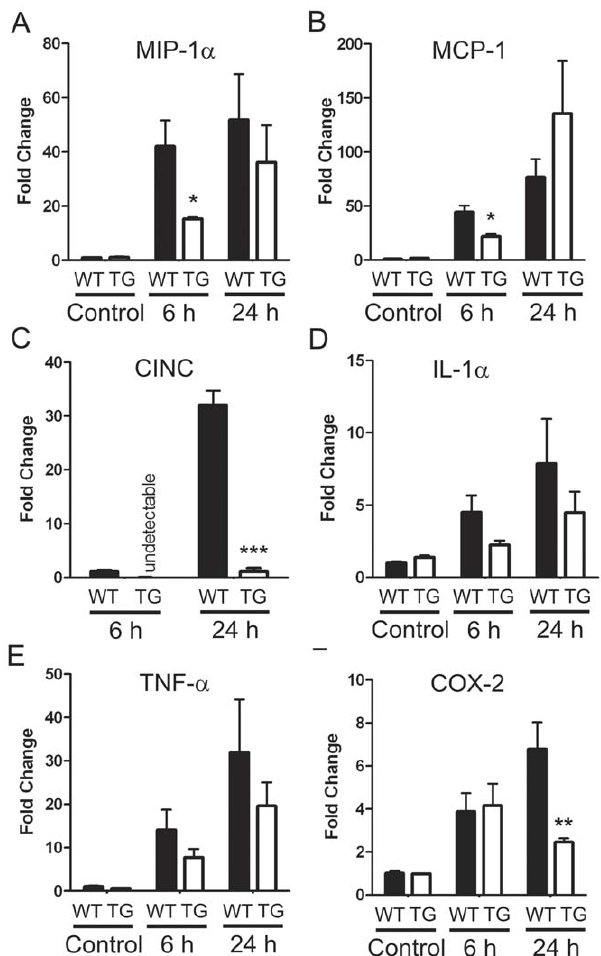
Figure 5. DSCR1-TG mice exhibit a reduction in inflammatory mediators following stroke. Cerebral ischemia results in increased mRNA levels for several inflammatory mediators in the brain over 24 h, including (A) MIP-1 a , (B) MCP-1 , (C) CINC , (D) IL-1 a , (E) TNF- a and (F) COX- 2 . Of note, expression of MIP-1 a (A) and MCP-1 (B) was delayed in DSCR1-TG, while CINC expression was virtually unchanged (C). COX-2 expression was reduced in the DSCR1-TG at 24 h after ischemia (F). The data are presented as mean 6 SEM (n=3 per group). (*P , 0.05, **P , 0.01, ***P , 0.001).